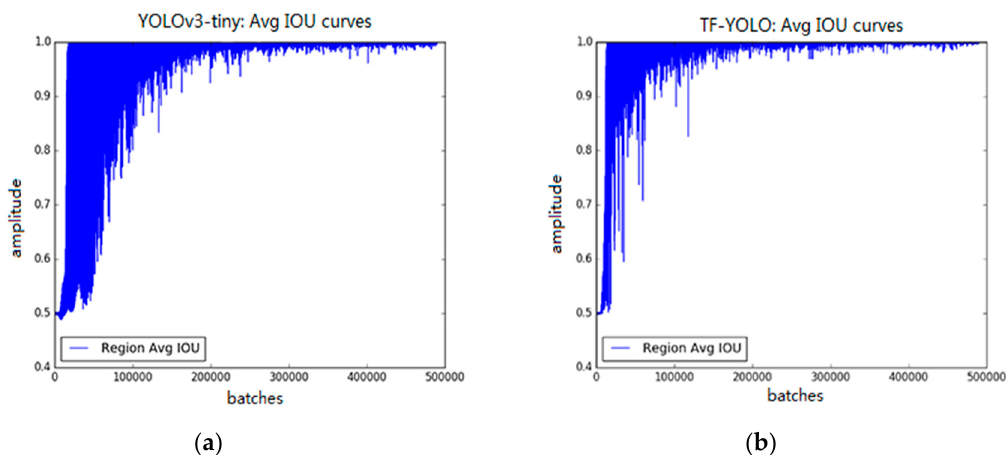
Figure 7. The comparison of intersection over union (IOU) curves obtained by two networks: ( a ) YOLOv3-tiny network; ( b ) TF-YOLO